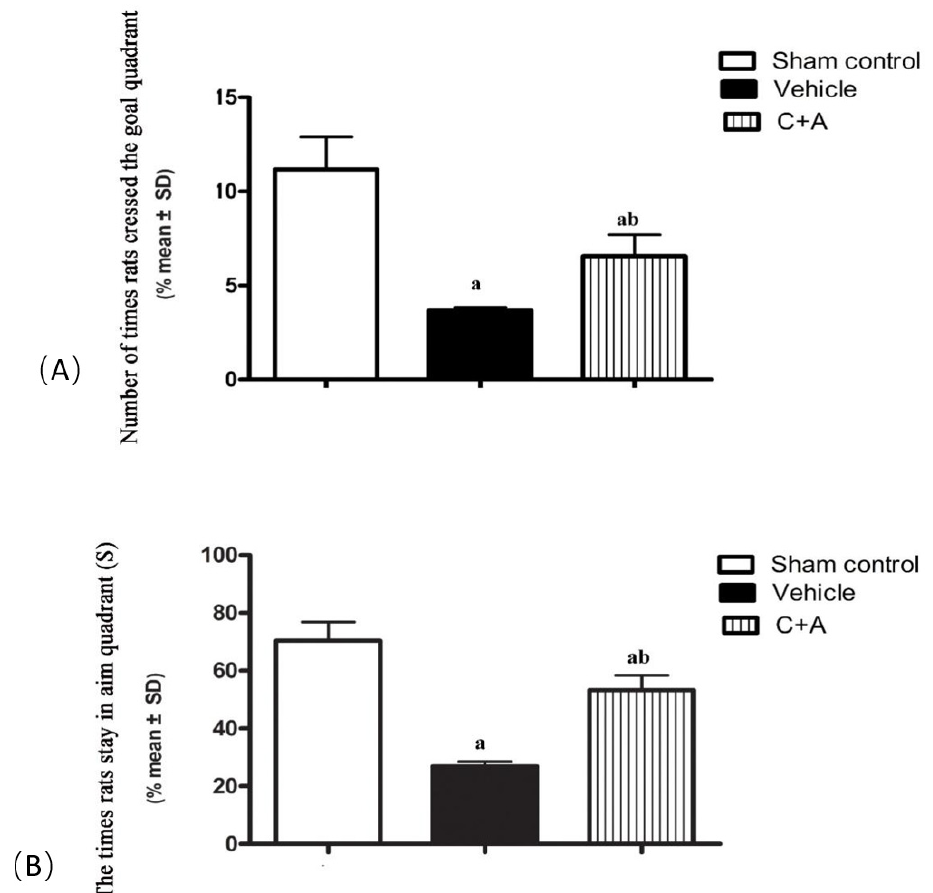
Figure 1. The results of the space exploration test showed that the number of times that rats crossed the platform quadrant ( A ) and the average time (s) that animals stayed in the platform quadrant ( B ) in the vehicle group were significantly decreased compared with the sham control. This phenomenon was effectively reversed by treatment with C16 plus Ang-1. a, p < 0.05 vs. sham control group; b, p < 0.05 vs. vehicle Table 1. The escape latency of three experimental groups in the positioning navigation test.